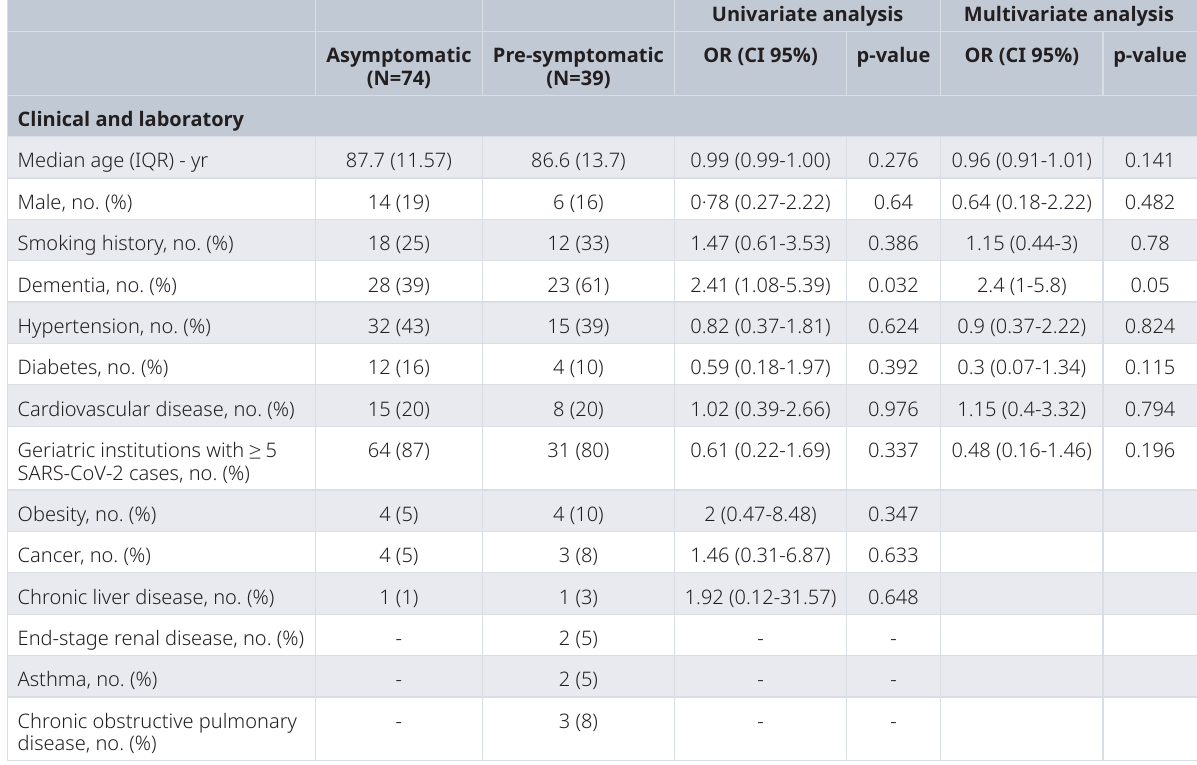
Table 1. Determinants of pre-symptomatic